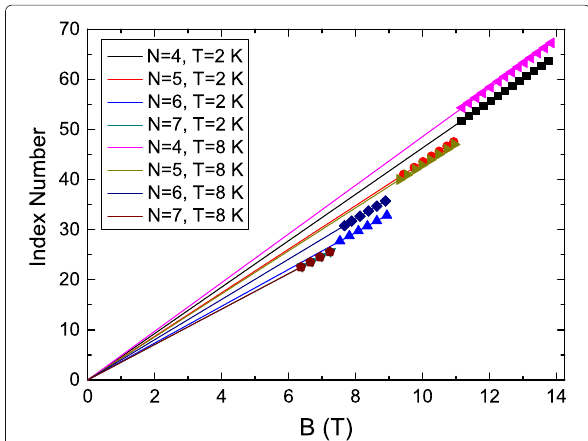
Fig. 5 The AB oscillation index number as a function of B at different Landau levels and temperatures. The intercept is 0.25 which indicates a 0.5 phase shift in the plot of the AB oscillation. This supports the Berry phase is